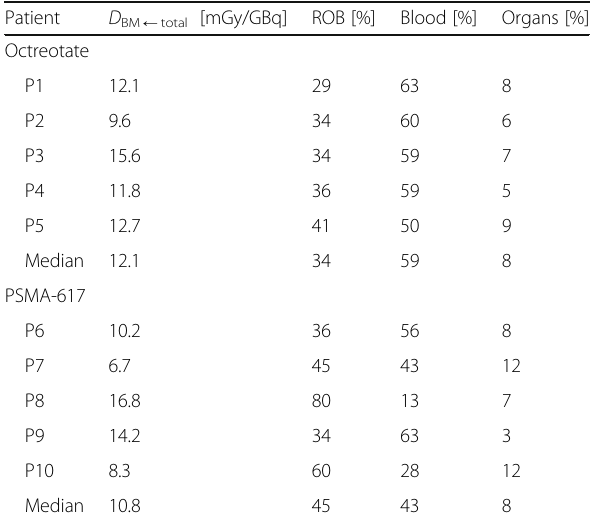
Table 3 Results from the reference protocol. Total bone marrow absorbed doses ( D BM ← total ) and the percentage contribution of ROB, blood, and organs to the total bone marrow absorbed dose. All percentage contributions were calculated according to Eq.